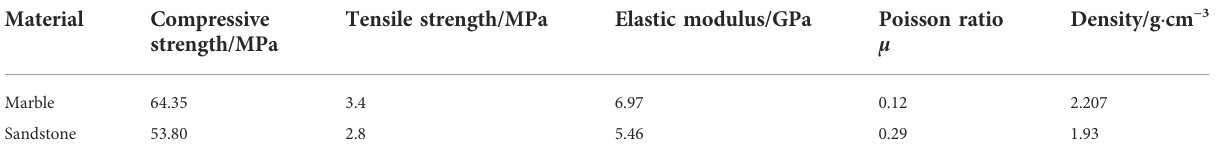
TABLE 2 Physical and mechanical parameters of two considered materials. Material